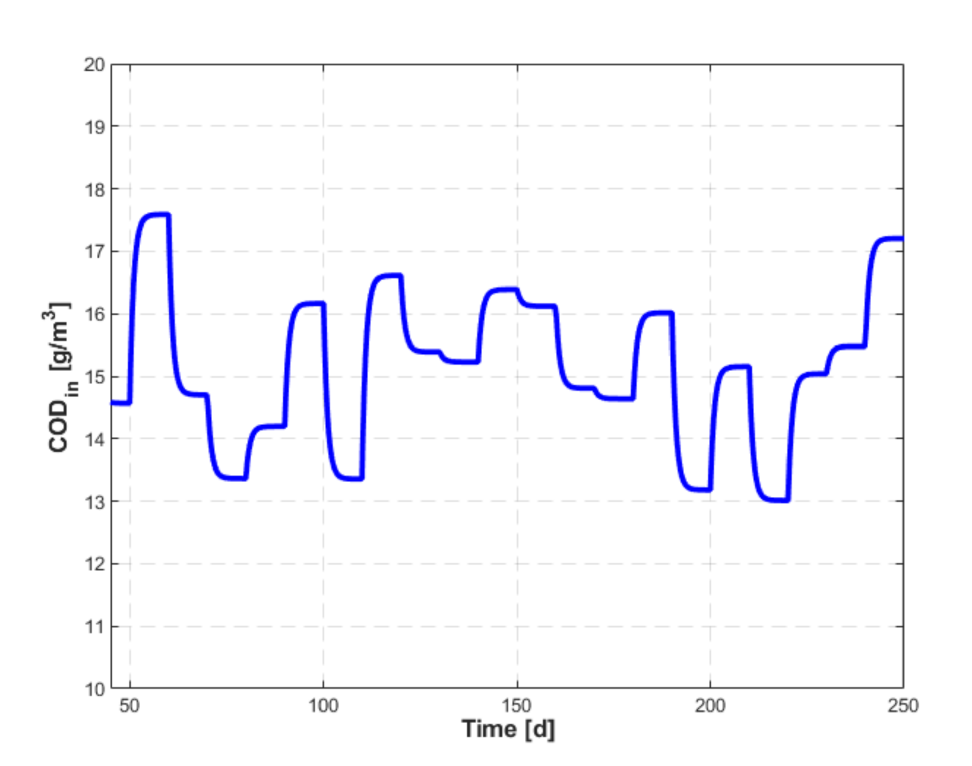
Figure 15. Evolution of the influent COD in .